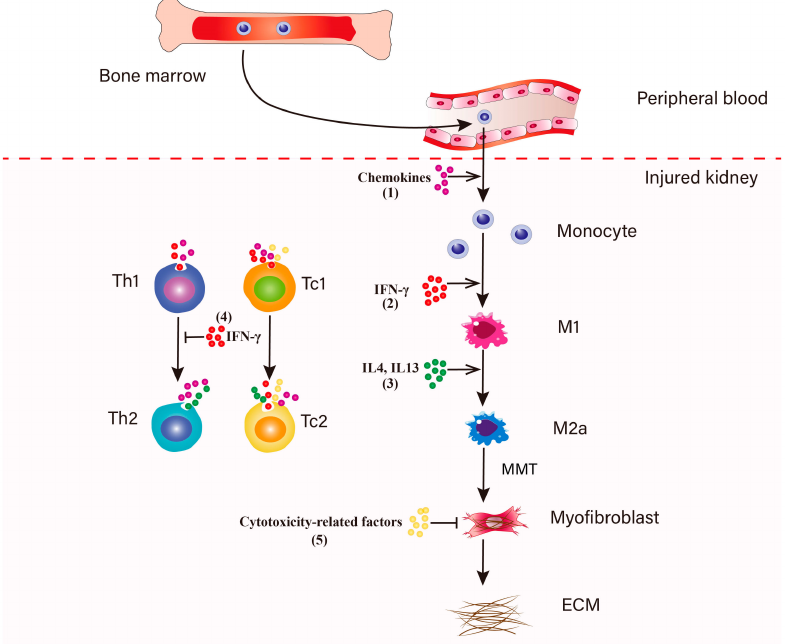
Figure 2. Regulation of macrophage-to-myofibroblast transition. (1) In response to kidney injury, the bone marrow increases the production and release of monocytes into the peripheral blood. Circulat- ing monocytes are recruited to the injured kidney, a process that is dependent on the chemokines partly secreted by resident T lymphocytes and macrocytes [118,119]. Recruited monocytes can proliferate in the kidney to amplify the inflammatory response. (2) IFN- γ produced by Th1 and CD8 + T lymphocytes promote macrophages polarization towards a pro-inflammatory M1 pheno- type [85,90]. (3) The infiltrated macrophages adopt an anti-inflammatory M2 phenotype in response to IL4 and IL13 which are expressed by Th2 and Tc2 cells [82]. The ongoing activation of TGF- β triggers macrophage transition from a M2a phenotype to myofibroblasts within the injured kidney (MMT) [38,39,66–69]. These MMT-derived myofibroblasts induce the accumulation and deposition of ECM and subsequently promote the development of renal fibrosis [38,39,43]. (4) During this process, two subsets of CD8 + T cells, Tc1 and Tc2 cells secrete IFN- γ to inhibit the differentiation of Th2 cells, which can prevent the Th2 cells-induced excessive polarization of M2a cells [34]. (5) Tc1 and Tc2 cells could secrete cytotoxicity-related factors to induce fibroblasts apoptosis, subsequently suppressing the expansion of